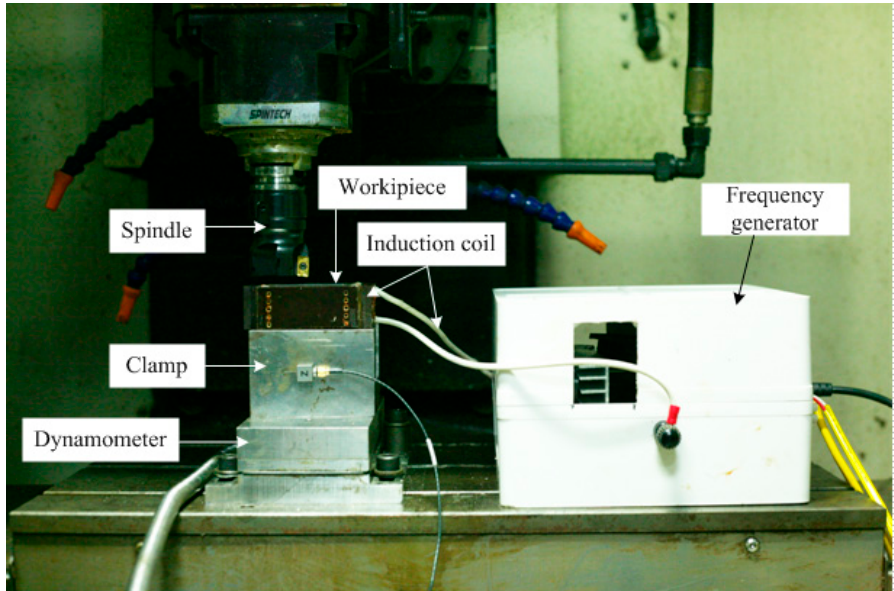
Figure 1. Photograph of experimental setup for induction-assisted milling of SKD11 steel.